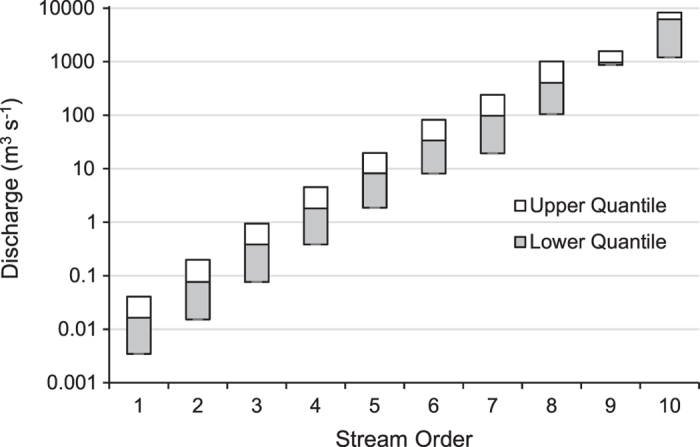
Thresholds for determining partitions between size classes.Box plots (upper and lower quantiles) of discharge according to stream order. Class breaks represent average values between corresponding medians for each stream order.